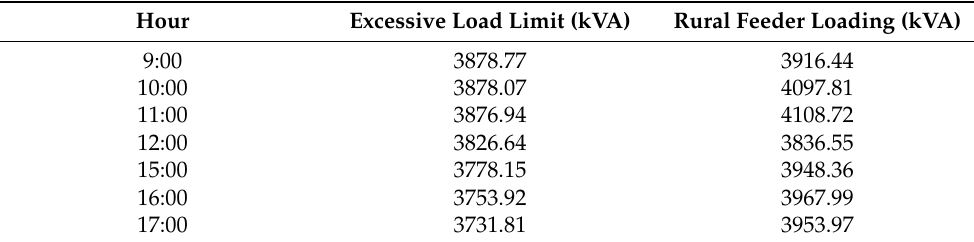
Table 4. Excessive loading limit violations on the Rural Feeder A. Source: The